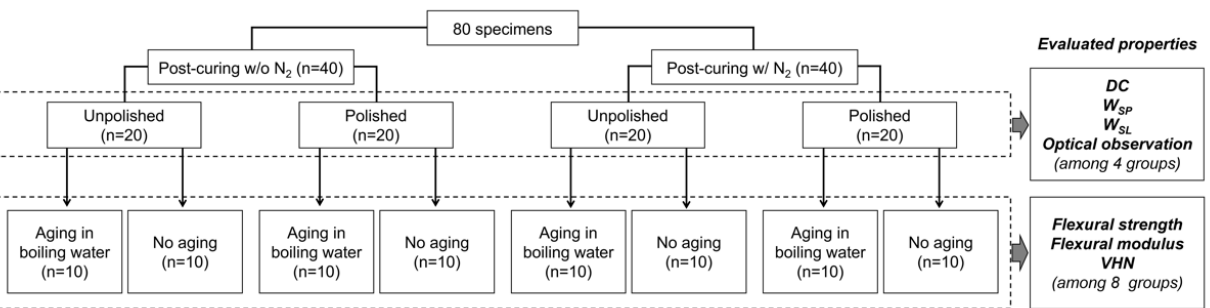
Figure 2. Flowchart of specimen fabrication. N 2 : nitrogen gas; DC: degree of carbon double bond conversion; W SP : water sorption; W SL : water solubility; and VHN: Vickers hardness number. Post- curing w/o N 2 : stroboscopic post-curing in the air atmosphere. Post-curing w/ N 2 : stroboscopic post- curing at a nitrogen gas atmosphere.